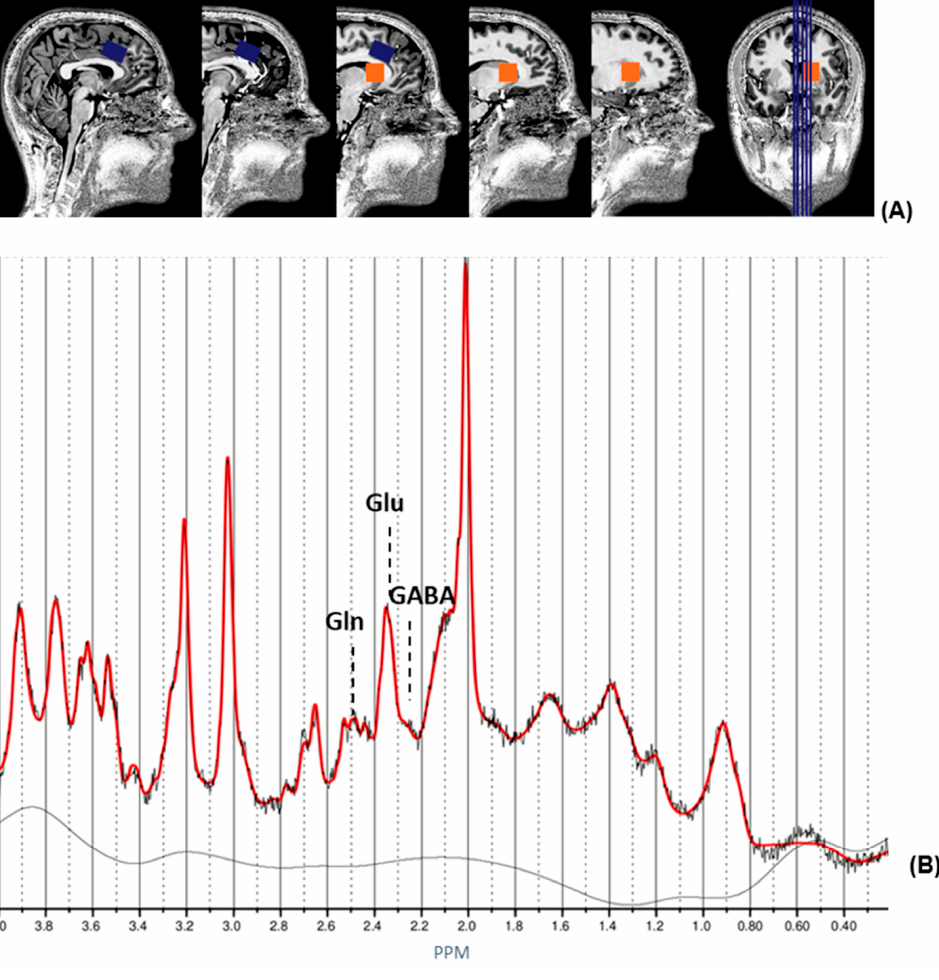
Figure 1. 1 H magnetic resonance spectroscopy (MRS) voxel placement and 1 H-MRS spectrum. ( A ) Sagittal and coronal views of MRS voxels displayed on a single subject’s T1 structural image. The blue lines in the coronal view (far-right image) indicate the locations of the sagittal views from left to right. The orange box indicates the location of the voxel in the striatum. The blue box indicates the location of the voxel in the ACC. ( B ) Example of an ACC spectrum from a healthy control acquired by LCModel. Reprinted from [21]. Abbreviations: ACC, anterior cingulate cortex; GABA, y-aminobutyric acid; Gln, glutamine; Glu, glutamate; PPM, parts per million.